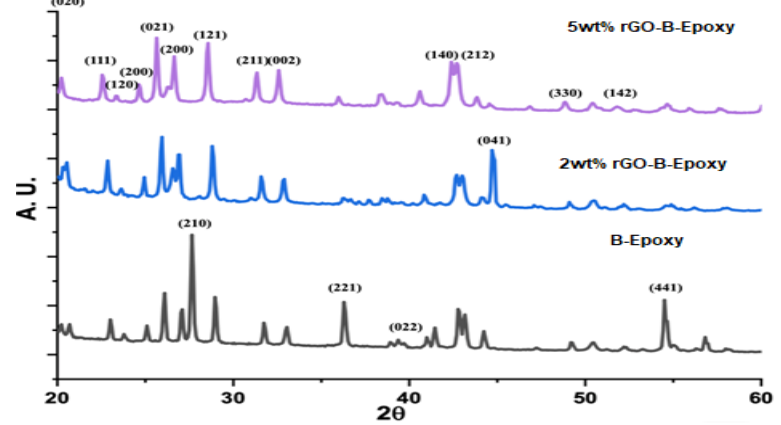
Figure 6. XRD results for B–epoxy and rGO–B–epoxy composites.